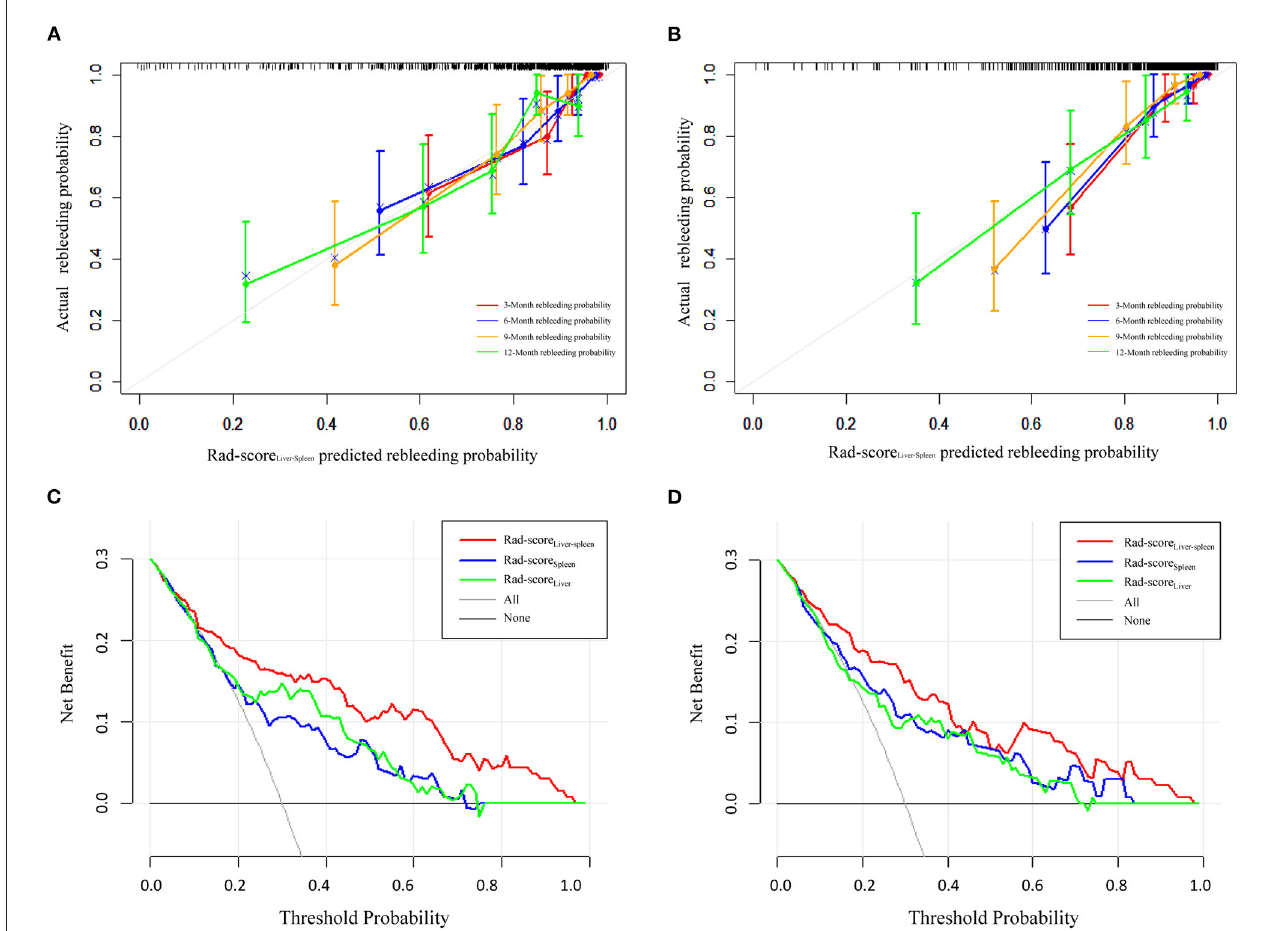
FIGURE 4 | Calibration curves and decision curve analysis of the Rad-score Liver − Spleen . Calibration curves of the Rad-score Liver − Spleen demonstrate its predictive performance for rebleeding at 3, 6, 9, and 12 months in the training cohort (A) and validation cohort (B) . Decision curve analysis was performed to compare the performance of the Rad-score Liver − Spleen , Rad-score Liver and Rad-score Spleen in the training cohort (C) and validation cohort (D)